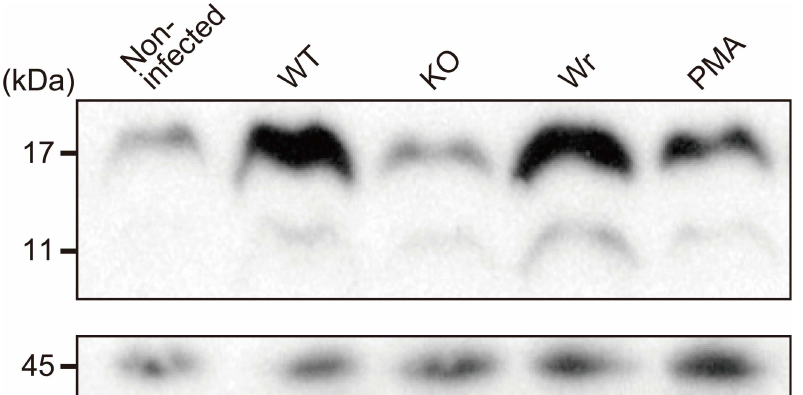
Fig 6. Detection of histone citrullination in S . sanguinis -infected neutrophils. Neutrophils were infected with the WT, KO, or Wr strain at an MOI of 10. Followingincubationfor 1 h at 37˚C, cells were suspendedin Laemmligel loadingbuffer. Samples were immunoblotted with a rabbit anti-histoneH3 antibodyand HRP- conjugated anti-rabbitIgG antibody(upper panel). As a loadingcontrol, β -actinwas detected using an anti- β - actin antibody and HRP-conjugatedanti-rabbitIgG antibody(lower panel).